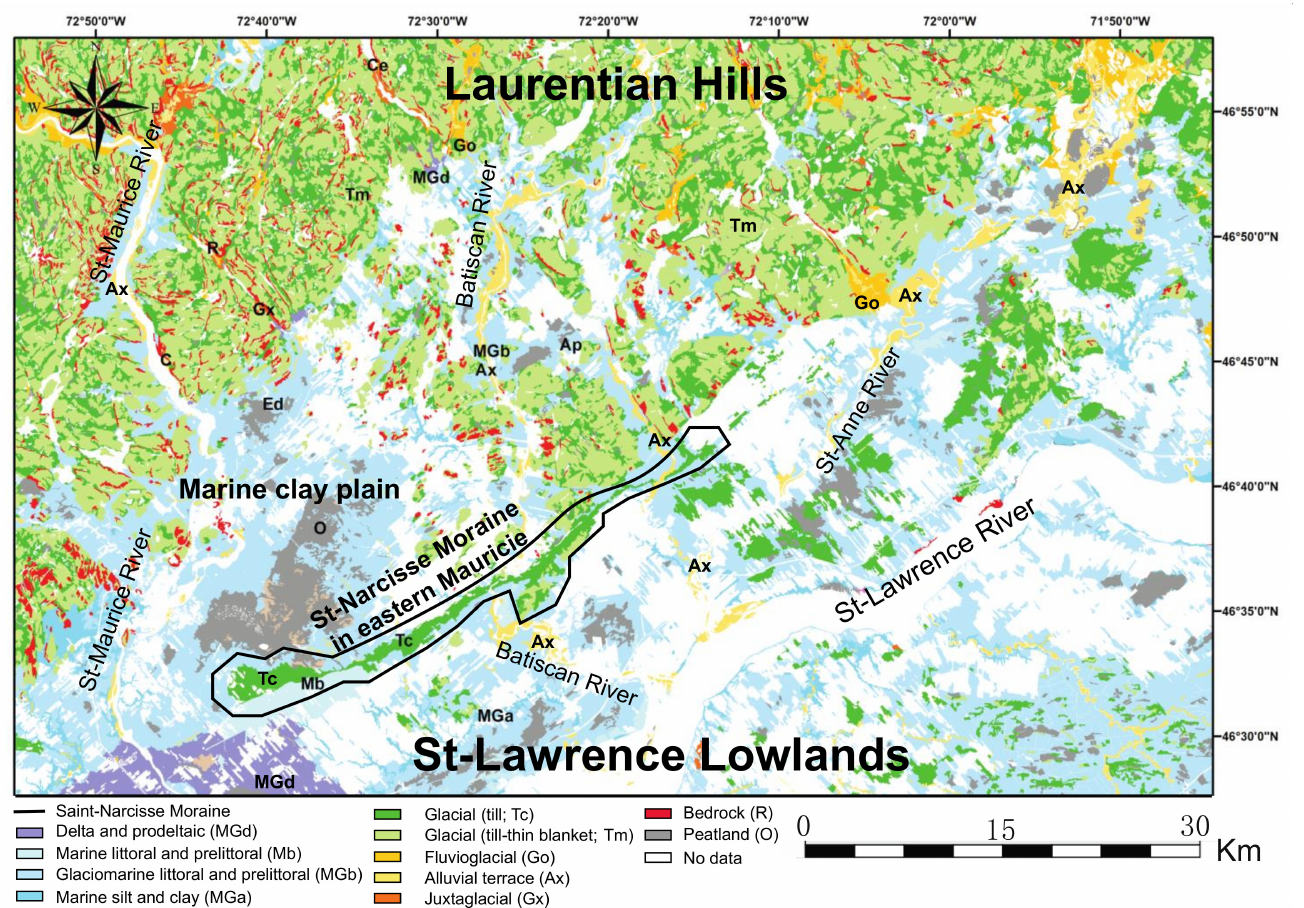
Figure 2. Surface deposit map of Quaternary sediments from the southeastern Mauricie region. The four main hydrogeolog- ical contexts are identified: Laurentian Mountains, marine clay, Saint-Narcisse moraine, and St. Lawrence